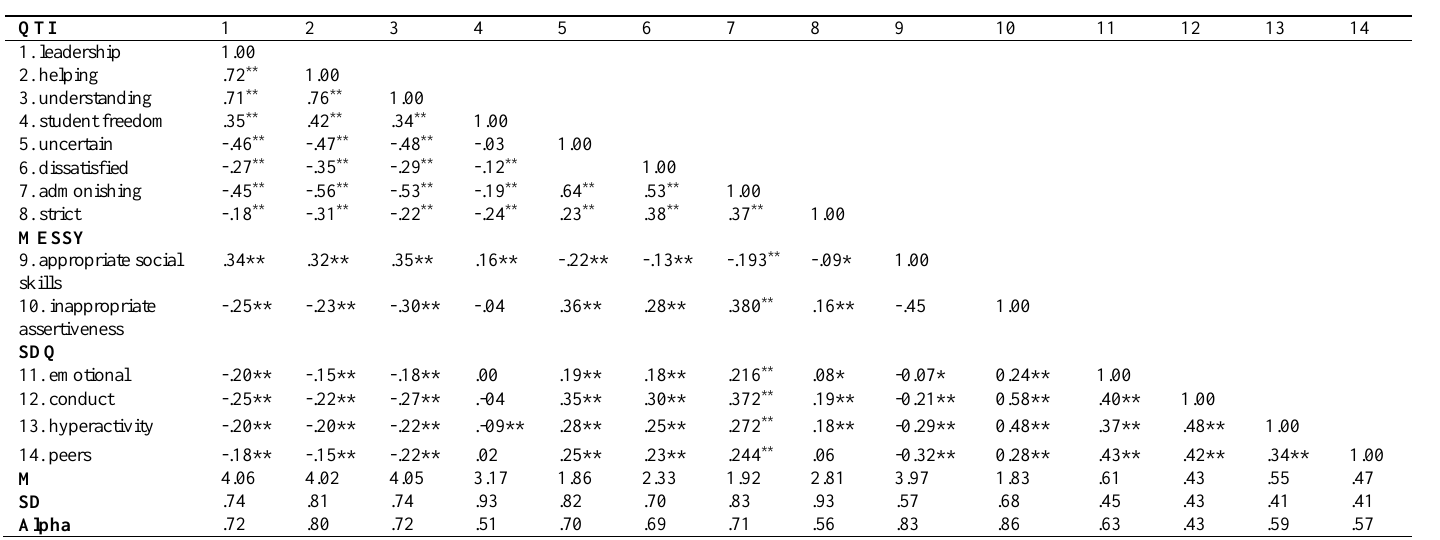
Correlation coefficients for the